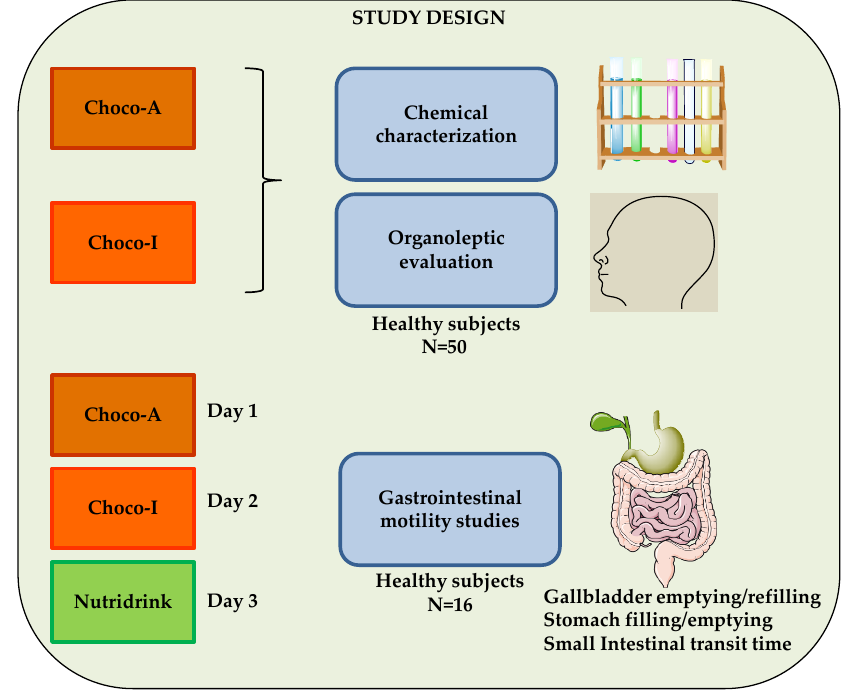
Figure 1. The diagram is shows the study design. Chemical analyses, organoleptic evaluation and clinical study of two dark chocolates compared with a standard meal (Nutridrink). Choco-A, artisanal; Choco-I, industrial.